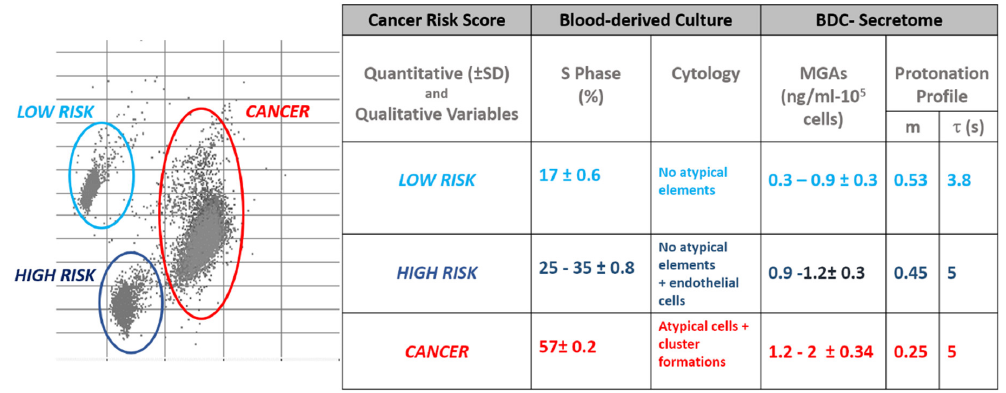
Figure 7. Matrix of the chemometric model. Equivalence between the experimental profiles defined as a function of quantitative and qualitative variables and exploratory classifying data of chemometric model prototype on BDCs and secretome. Supplementary Materials: Supplementary Table S1 Excel file. Clinical and Experimental details of subjects involved.